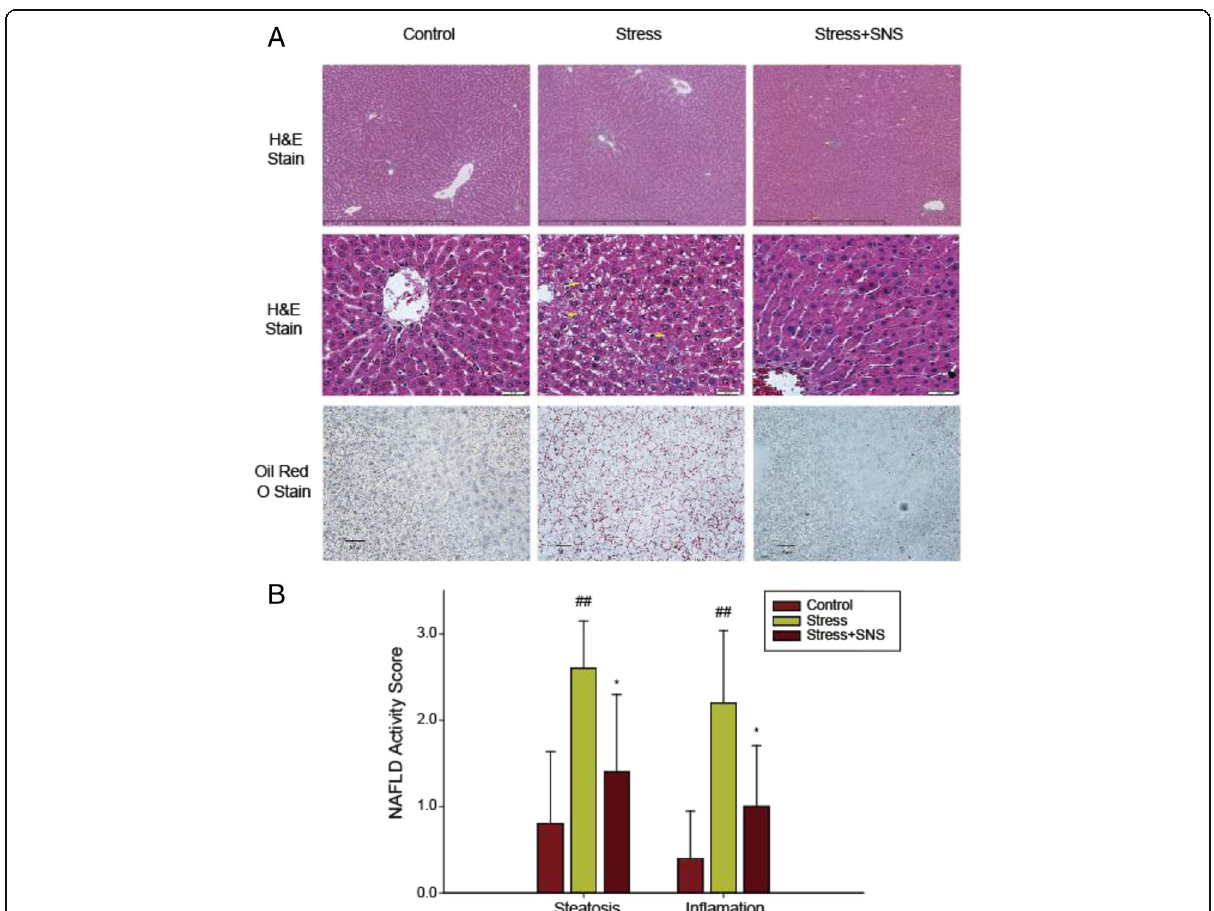
Fig. 6 Photomicrographs of histological changes in the rat liver. a Representative slides show hematoxylin and eosin (HE)-stained and oil red O-stained liver sections from rats of each group. HE sections show chronic stress causing foci of inflammatory cell infiltration and lipid deposits (yellow arrows) (original magnification, ×100 and ×400, respectively). b The nonalcoholic fatty liver disease (NAFLD) activity score was evaluated using the New York NAFLD score system. Values plotted are a mean ± standard deviation ( N = 10 per group). ## p < 0.01 versus the control group, * p < 0.05 versus the stress